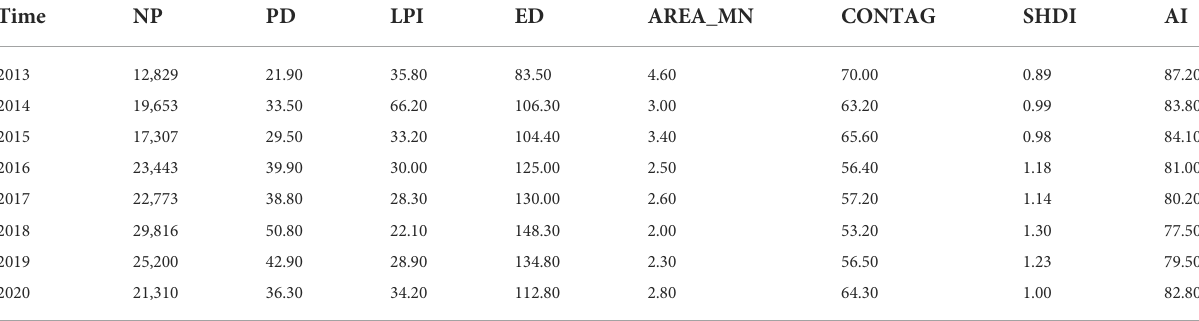
TABLE 9 Ecological Landscape Index of Jiuzhaigou Nature Reserve from 2013 to 2020. Time